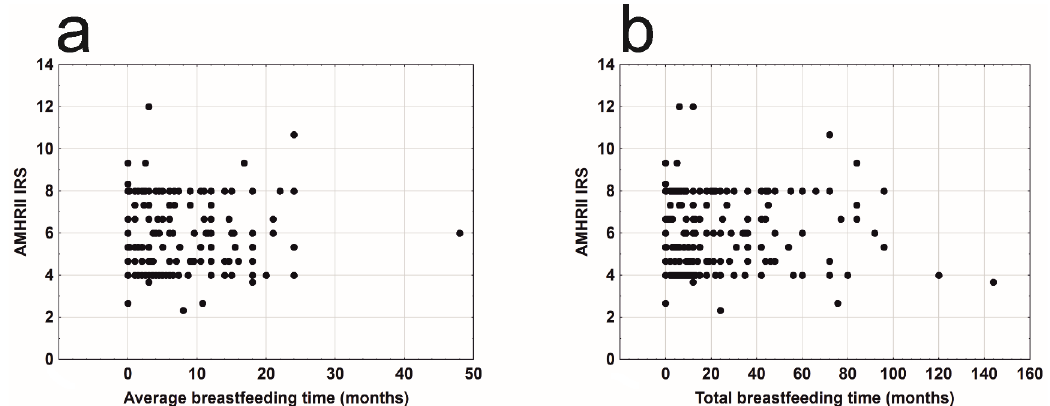
Figure 5. Mean AMHRII expression due to: ( a ) average breastfeeding time (r s = −0.049, n = 227, p = 0.459); ( b ) total breastfeeding time (r s = −0.030, n = 227, p = 0.650).